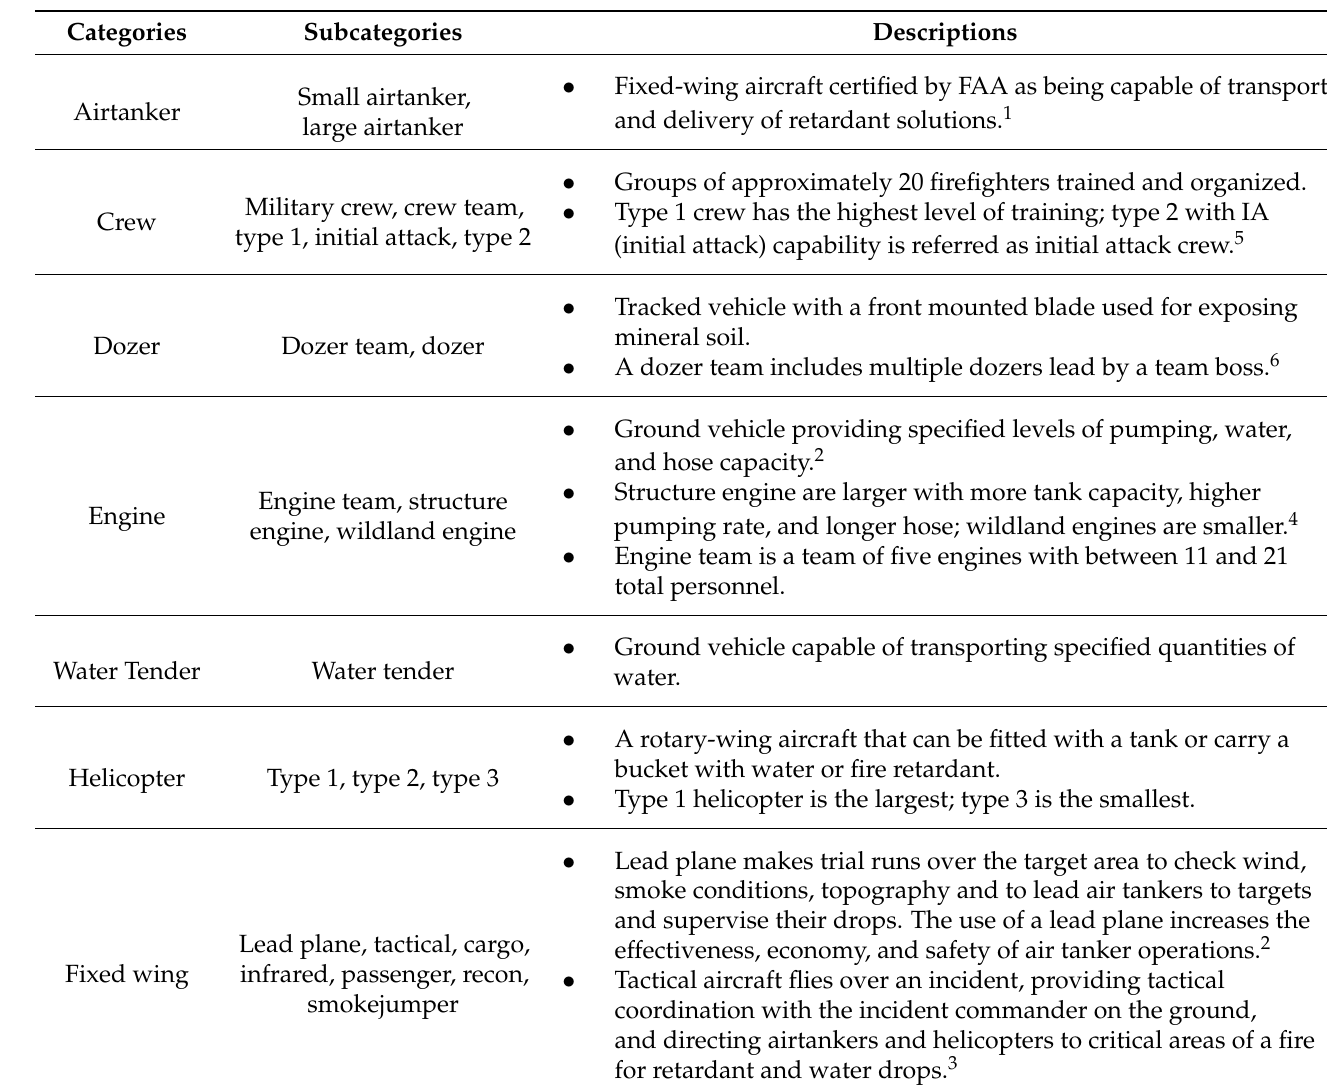
Table 1. Suppression resource categories and subcategories used in the